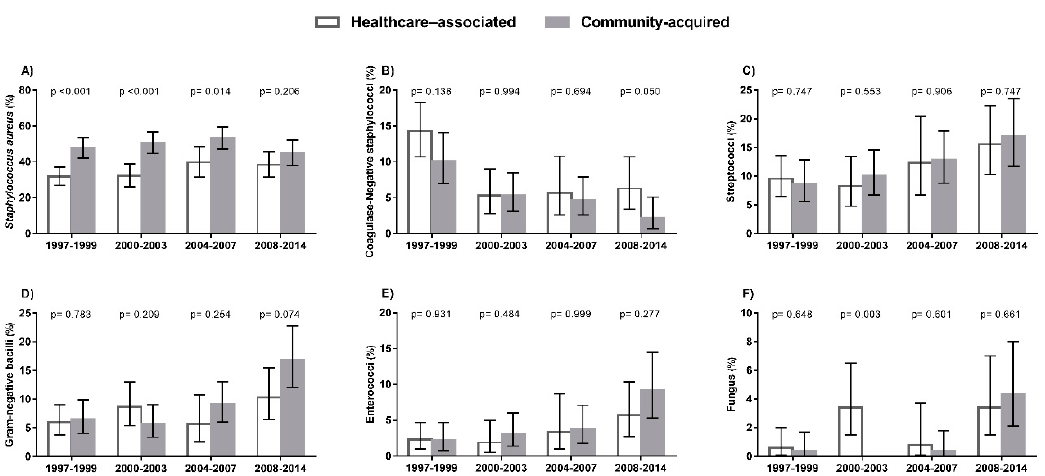
Figure 5. Epidemiological trends of causative microorganisms of infective endocarditis in HIV-infected patients in Spain (1997 to 2014) stratified by health care-associated and community-acquired endocarditis. ( A ) Staphylococcus aureus . ( B ) Coagulase-Negative staphylococci. ( C ) Streptococci. ( D ) Gram-negative bacilli. ( E ) Enterococci. ( F ) Fungus. Statistical: Differences between groups were calculated by the Chi Square test. Linear trends from 1997 – 1999 to 2008 – 2014 calculated by the Extended Mantel – Haenszel Chi Square.